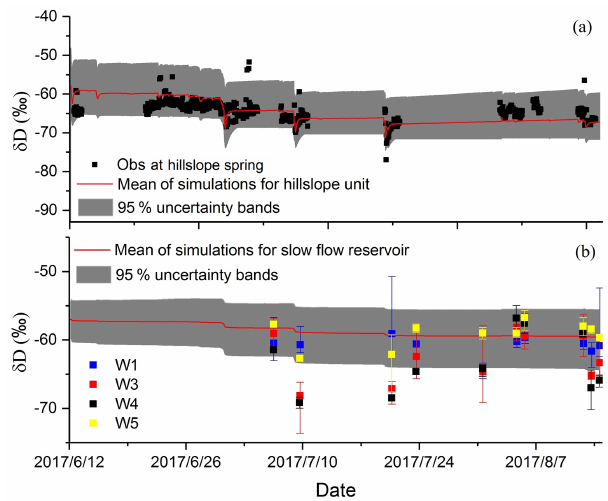
Figure 7. Modelled isotope signature at hillslope unit and slow reservoir vs. observation at hillslope spring and depression wells (the red line represents the mean of the simulations for the best 500 parameter sets).